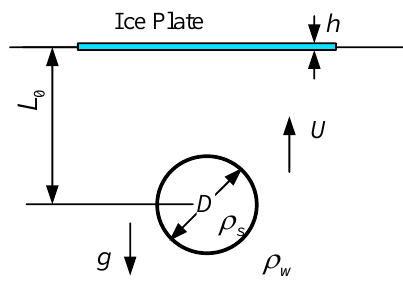
Figure 1. Sketch of the problem.